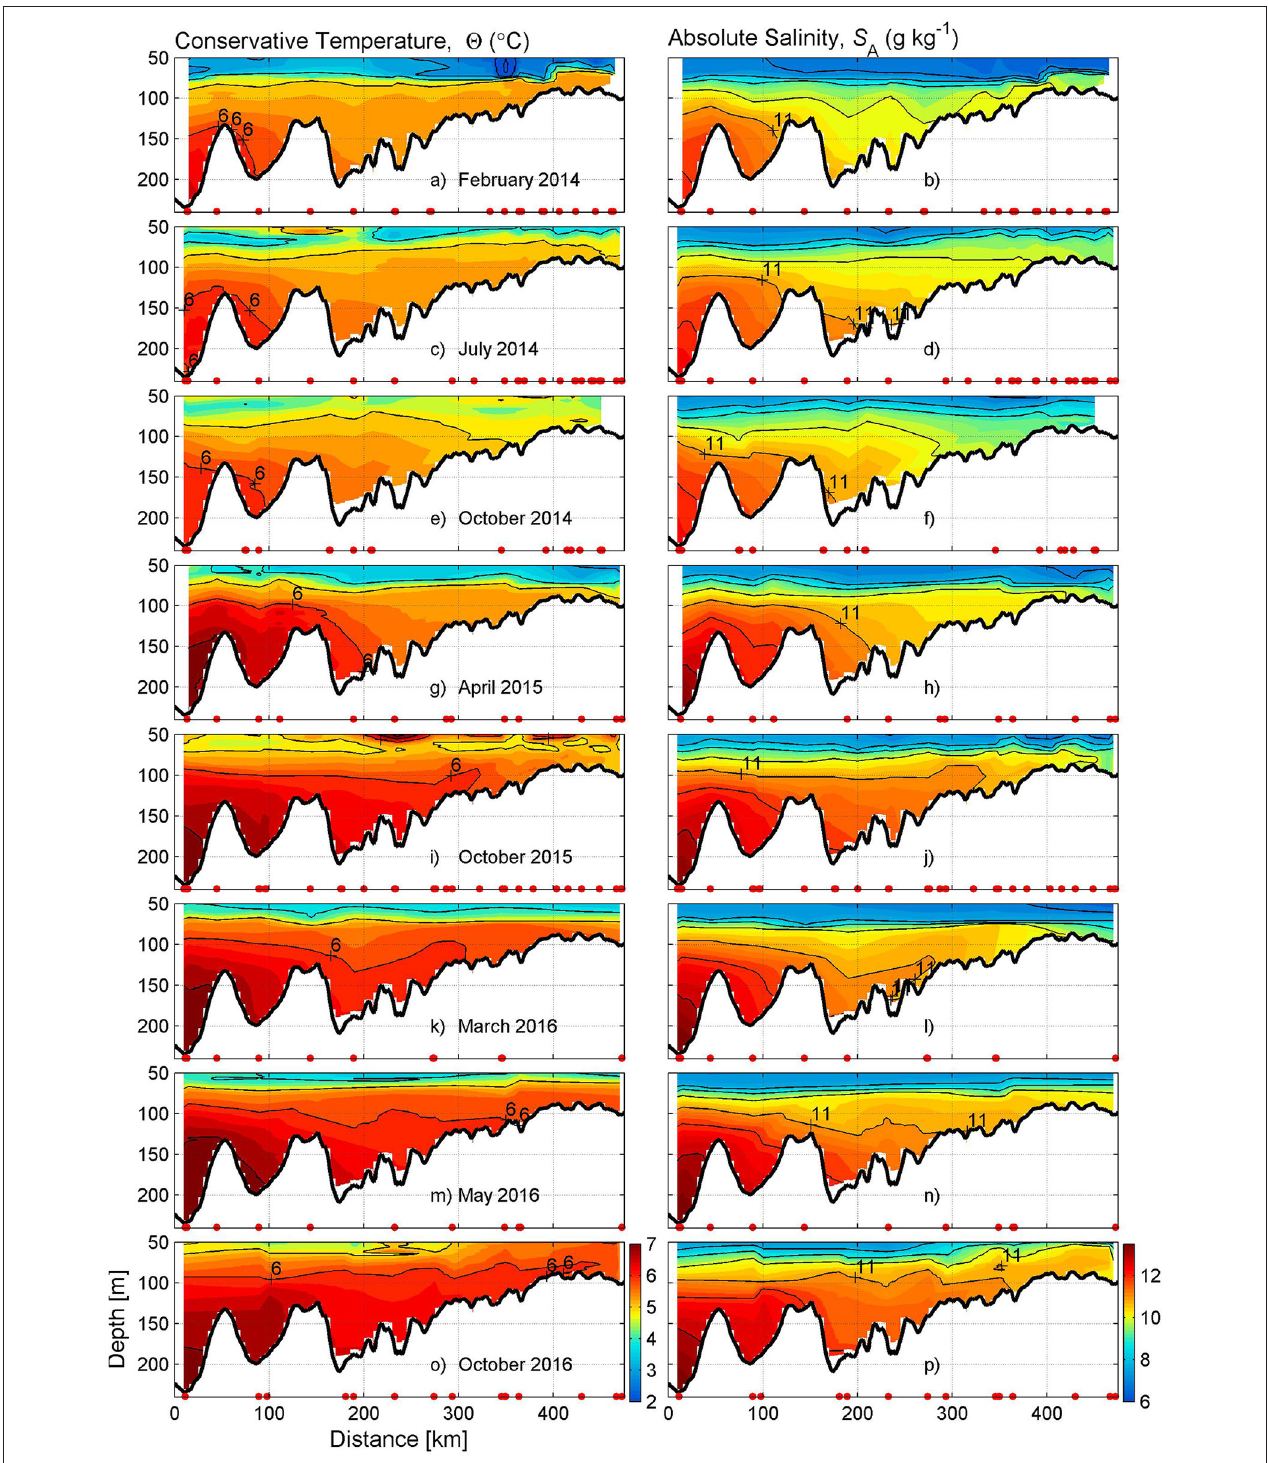
FIGURE 2 | Vertical sections of monthly mean temperature and salinity along the pathway from the Gotland Deep to the Gulf of Finland (see Figure 1A ) in February 2014 (a, b) , July 2014 (c,d) , October 2014 (e, f) , April 2015 (g, h) , October 2015 (i, j) , March 2016 (k, l) . May 2016 (m, n) , October 2016 (o, p) . Red dots on x-axis represent the locations of the CTD stations used. Black solid isolines are shown by 1 ◦ C and 1g kg − 1 step.